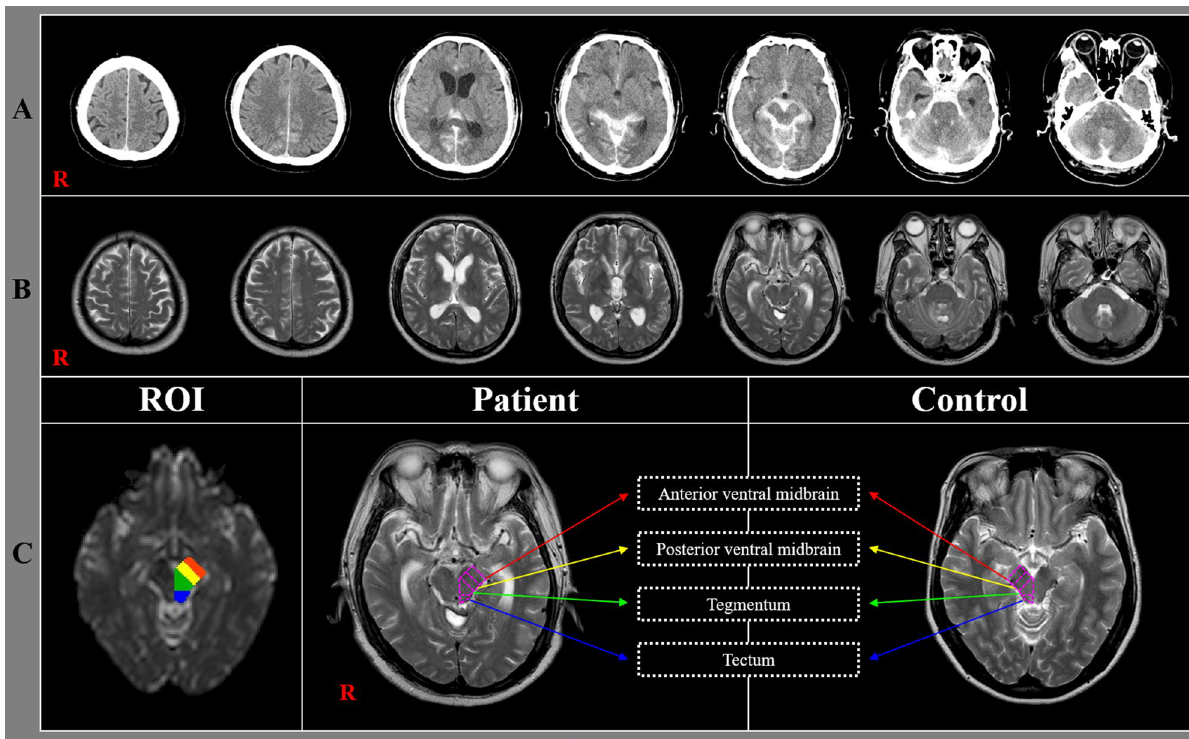
Figure 1. ( A ) Brain computed tomography images at onset reveal subarachnoid hemorrhage in a representative subject (68-year-old male) of the patient group. ( B ) T2-weighted brain magnetic resonance images obtained at the time of diffusion tensor imaging scanning; ( C ) Four regions of the midbrain examined by diffusion tensor imaging of the midbrain. Anterior ventral midbrain Posterior ventral midbrain Tegmentum Tectum Patient FA